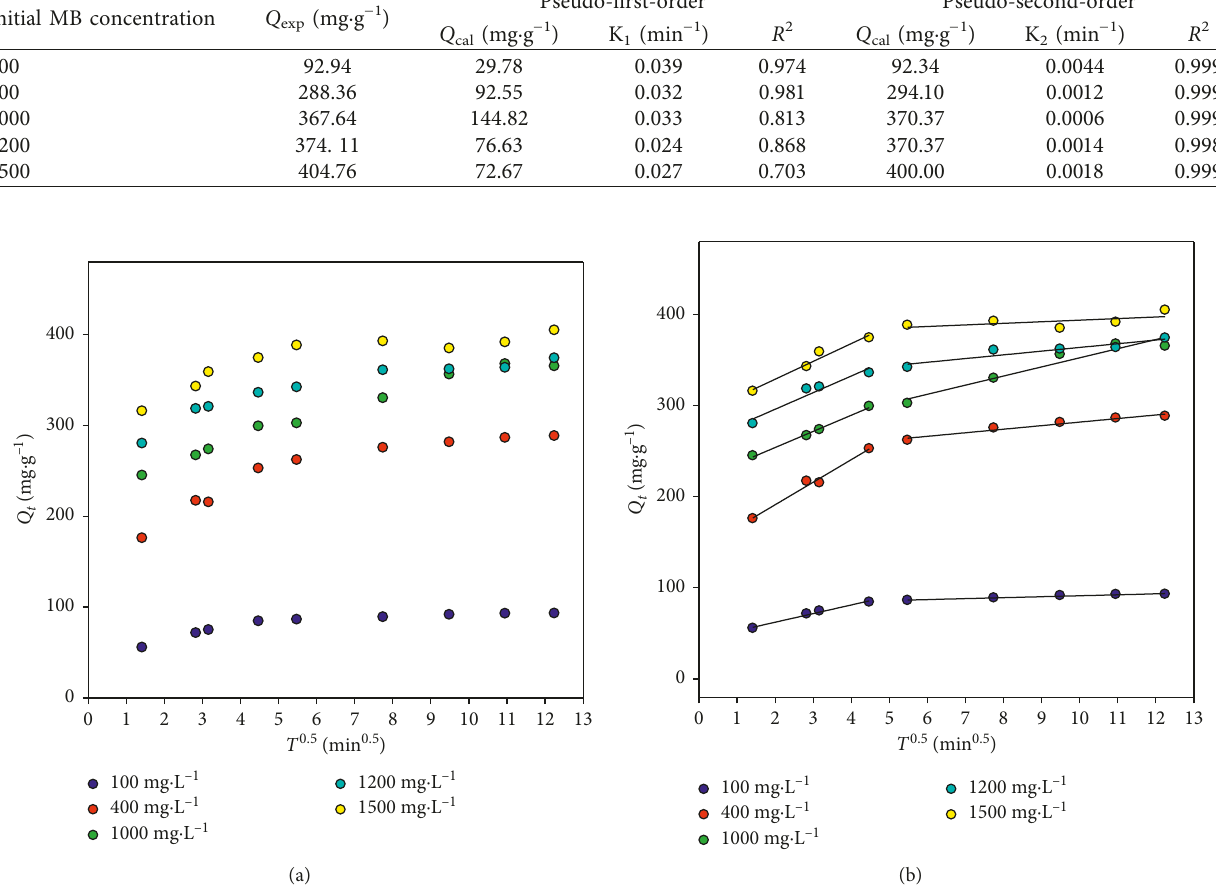
Figure 9: The plot of intraparticle diffusion model for the adsorption of MB at various initial concentrations. (a) The original plot and (b) the fitting results.